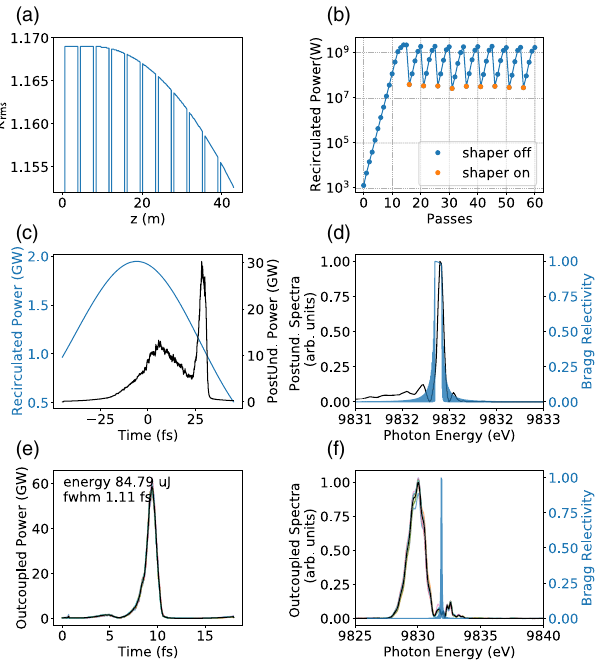
FIG. 3. Femtosecond pulses outcoupling. Undulator taper configuration (a), recirculated peak power for each iteration (b). Here the orange dots represent the shots when the shaping laser is on. Power profile after the undulator (black) and recirculated radiation profile (blue) from seed beam (c), a spectrum of the radiation after the undulator (d), 10 shots of outcoupled radiation from the shaped beam (e) and their spectrum (f), with colored lines for each shot and a black line for the average. Bragg reflectivity as a function of photon energy is shown by the blue line in (d) and